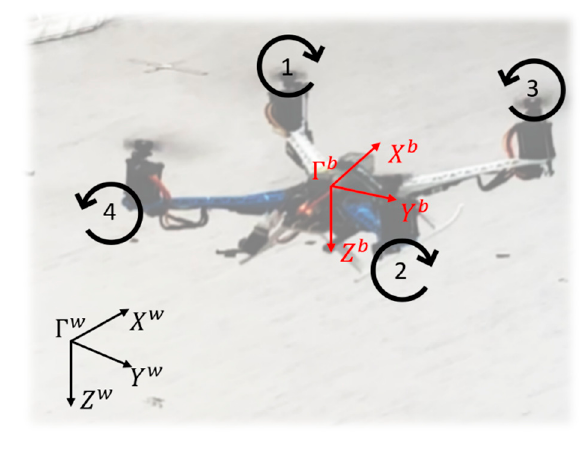
Figure 2. Coordinate system.